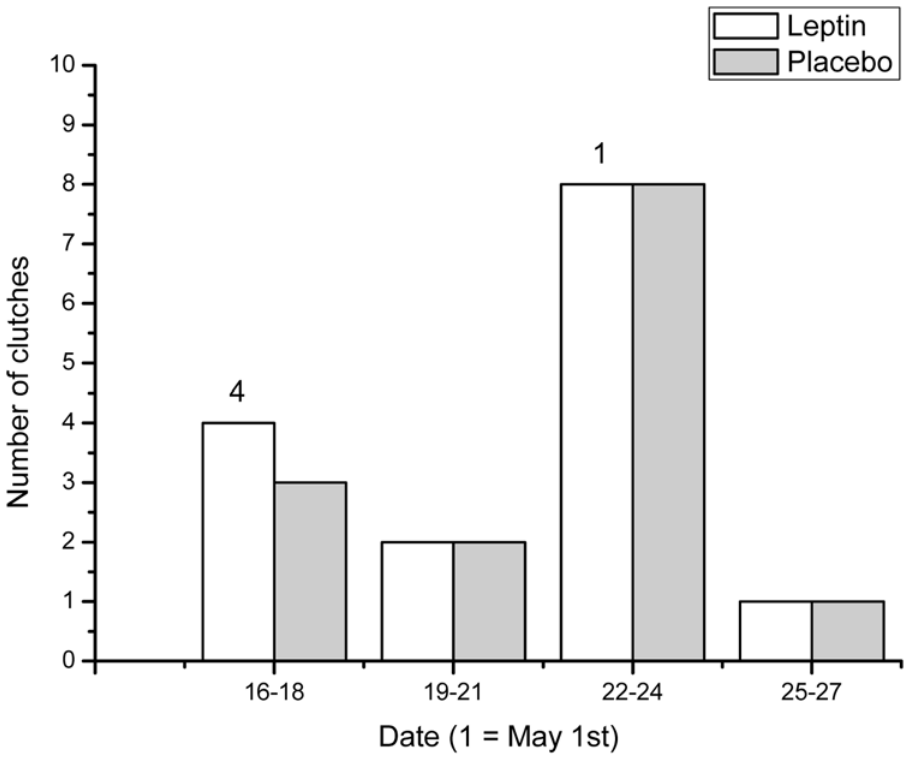
Figure 1. Hatching dates (in three-day bins) of leptin-treated and placebo-treated females. Numbers represent females that laid second broods.